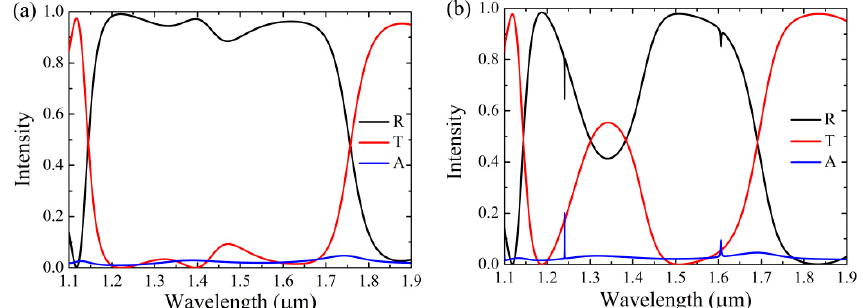
Figure 2. Spectral responses of the Si-based PCS under the TM-polarized normal incident wave. The parameters are: p = 690 nm, d 1 = 438 nm, d 2 = 249 nm, w = 345 nm. ( a ) s = 0. ( b ) s = 10 nm.